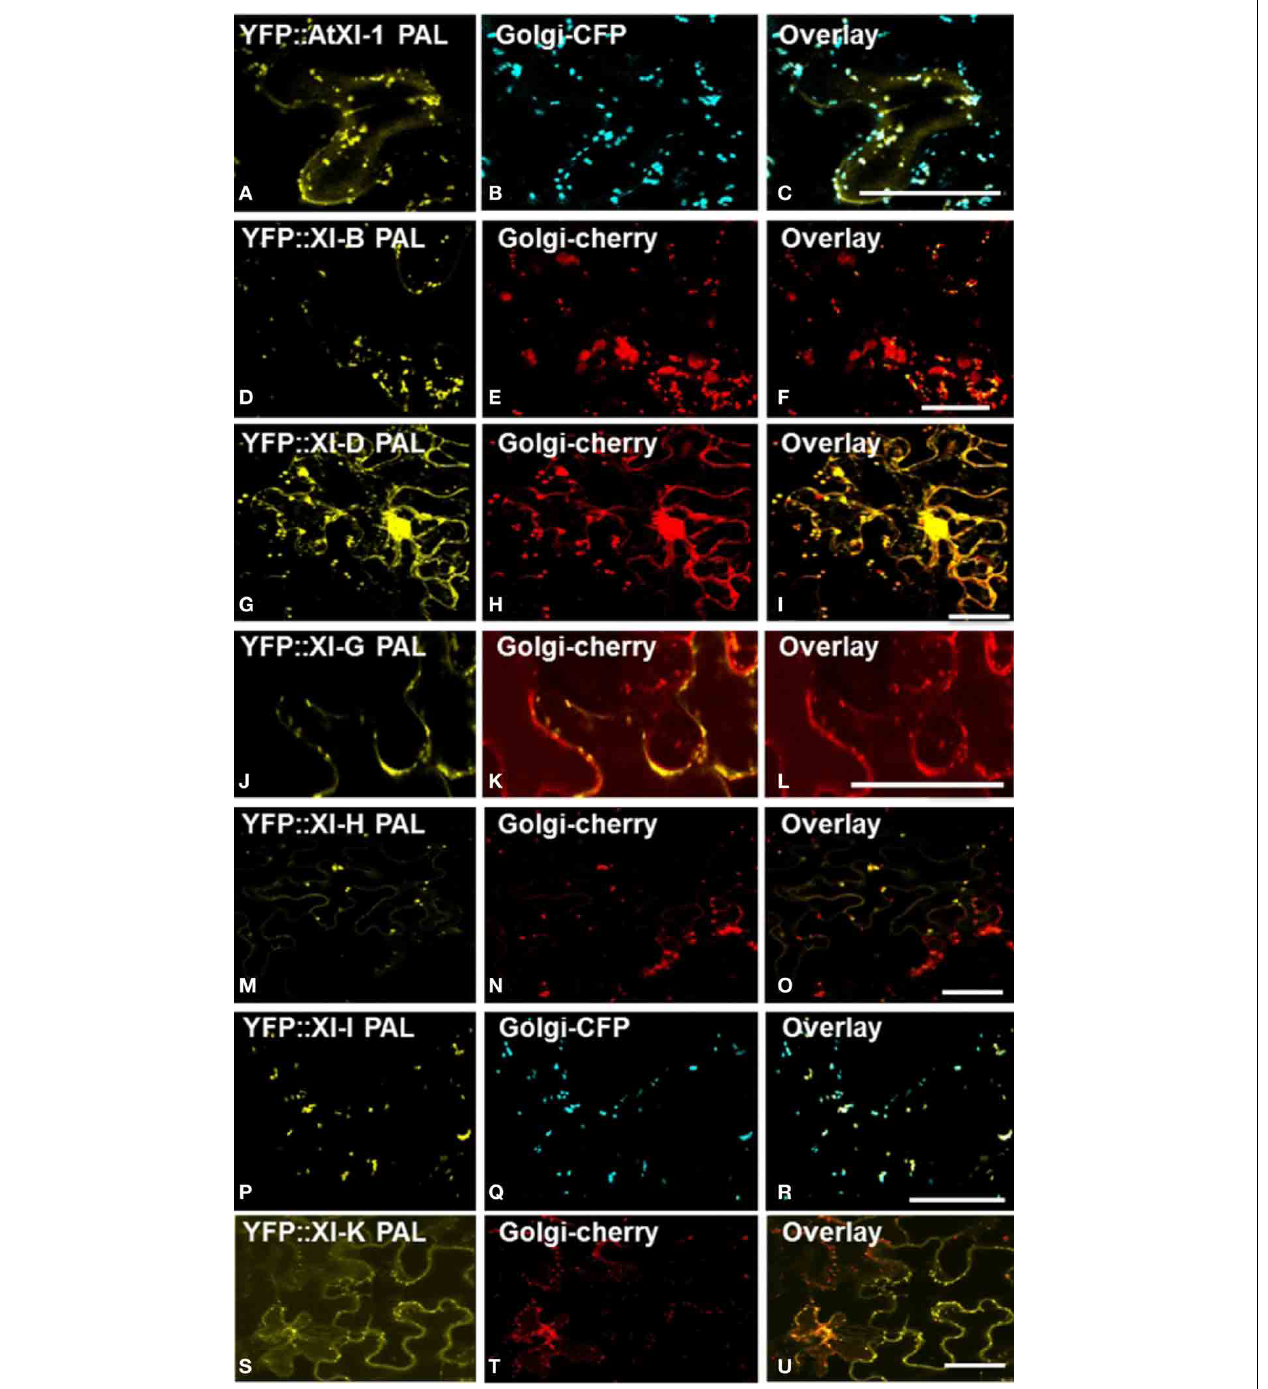
FIGURE 3 | Co-expression of YFP::Myosin XI PAL sub-domain with CFP and mCherry markers for Golgi in epidermal leaf cells of N. benthamiana (A) At XI-1. (D) At XI-I B. (G) At XI-D. (J) At XI-G. (M) At